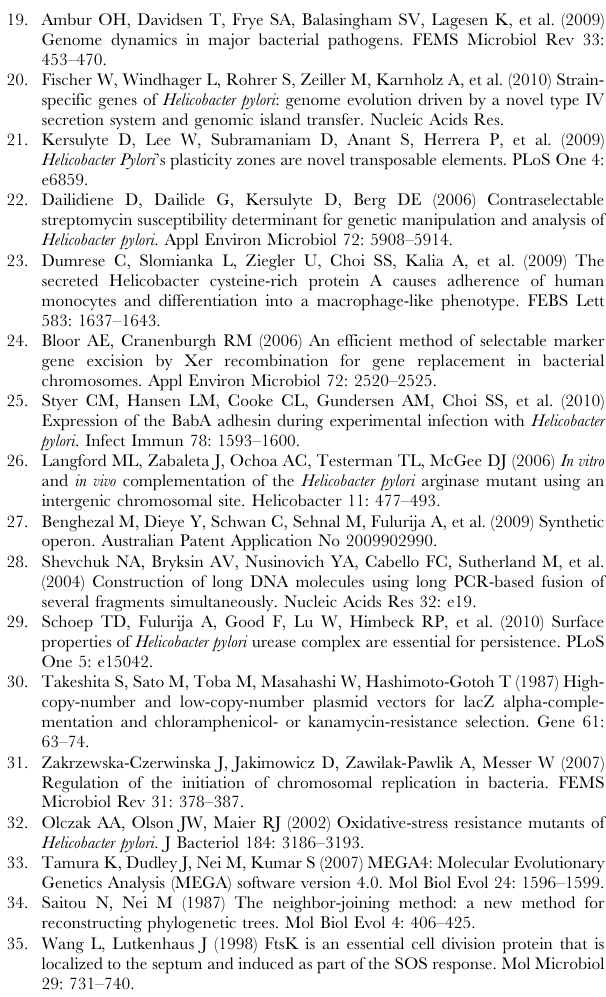
Figure S1 Positions of putative KOPS sequences and other features in the H. pylori 26695 genome sequence. The H. pylori 26695 genome sequence was scanned for the octameric AGTAGGGG sequences that had been implicated computationally as likely to affect chromosome architecture [6] (A), and for the GGGNAGGG octamer that constitutes the KOPS sequence of E. coli [49] (B). The circular H. pylori genome is presented here as a linear structure, with ends corresponding to its origin of bidirectional replication. The AG- TAGGGG and GGGNAGGG octamers are represented by red and blue plain diamonds, respectively. Also indicated are the locations of xerH and difH , and the HP0203-HP0204 and ureAB loci at which we had placed difH repeat cassette. Figure S2 Sensitivity of H. pylori mutants to oxidative stress. Sensitivity to oxidative stress was evaluated in a disk assay using 2 mM or 20 mM of paraquat on blood agar plates that had previously been streaked for confluent growth with either mutant or wild-type cells as indicated. Following a 3–4 day incubation period, the clear zones surrounding the disks were measured. Experiments were repeated three times and standard deviation is indicated.